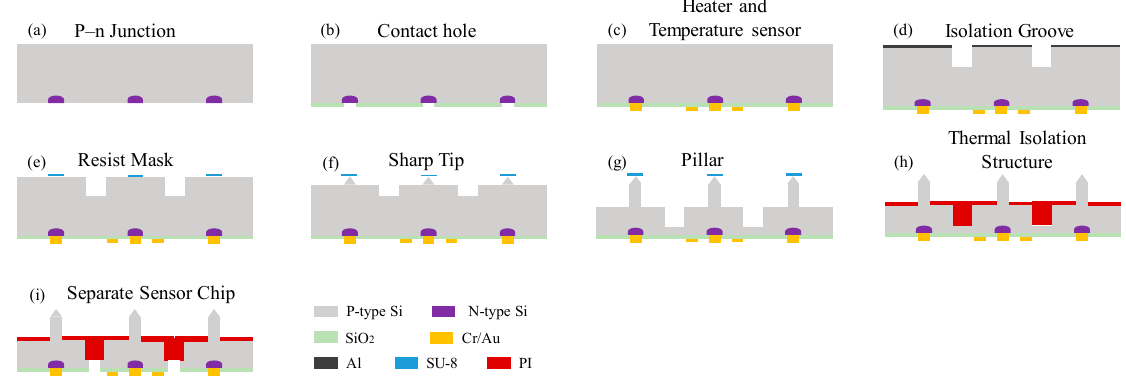
Figure 3. Fabrication process of the proposed